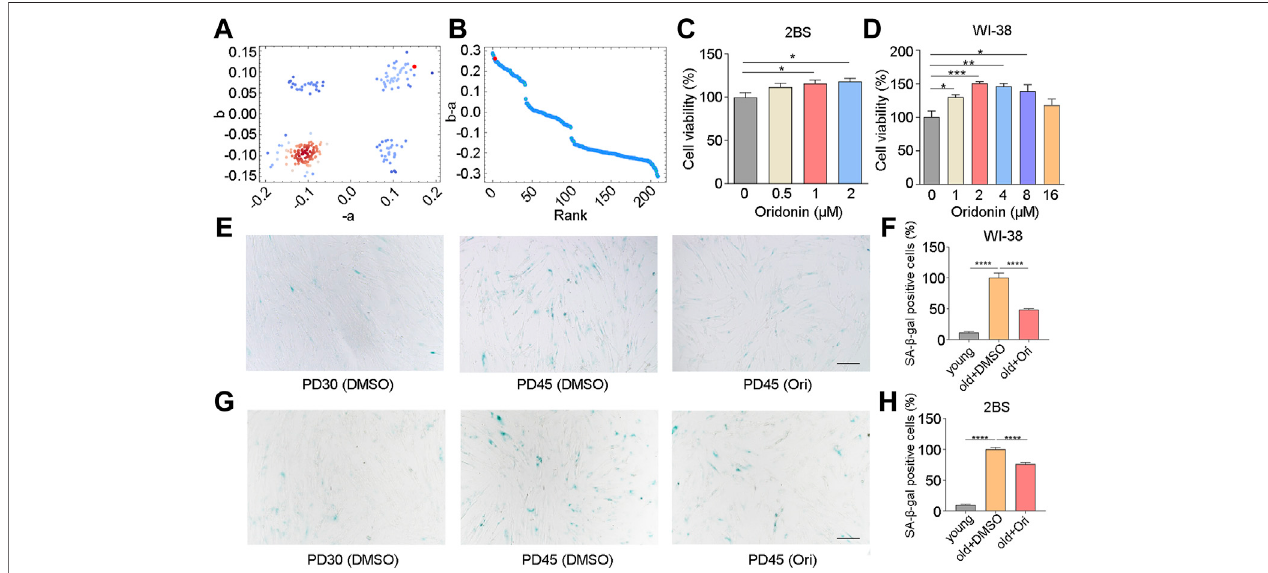
FIGURE1| OridoninscreenedbyCMAPdelayscellsenescence. (A – B) Predictionofanti-agingef fi cacyusingCMAP.Reddotsindicatetestedsmallmolecules. (C) The effect of different concentrations of oridonin on the proliferation of PD45 2BS cells was measured by the CCK-8 assay. (D) The effect of different concentrations of oridonin on the proliferation of PD45 WI-38 cells was measured by the CCK-8 assay. (E) SA- β -gal staining of PD45 WI-38 cells treated with 2 µM oridonin or DMSO for 48 h, Bar = 200 µm. (F) Quanti fi cation of the rate ofSA- β -gal positive cells in PD45 WI-38 cells. (G) SA- β -gal stainingof PD45 2BS cells treated with 2 µM oridonin or DMSO for 48 h, Bar = 200 µm. (H) Quantify the proportion of SA- β -gal positive cells in PD45 2BS cells (C-H, n ≥ 3 for each group). Data represent the mean ± SEM. one-way ANOVA or Student ’ s t-test determined p values. (* p < 0.05, ** p < 0.01, *** p < 0.001, **** p <